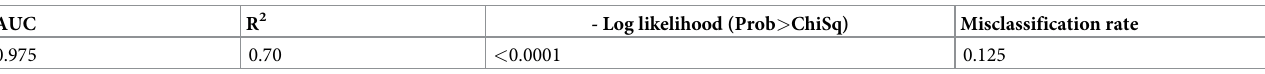
Table 6. Whole model